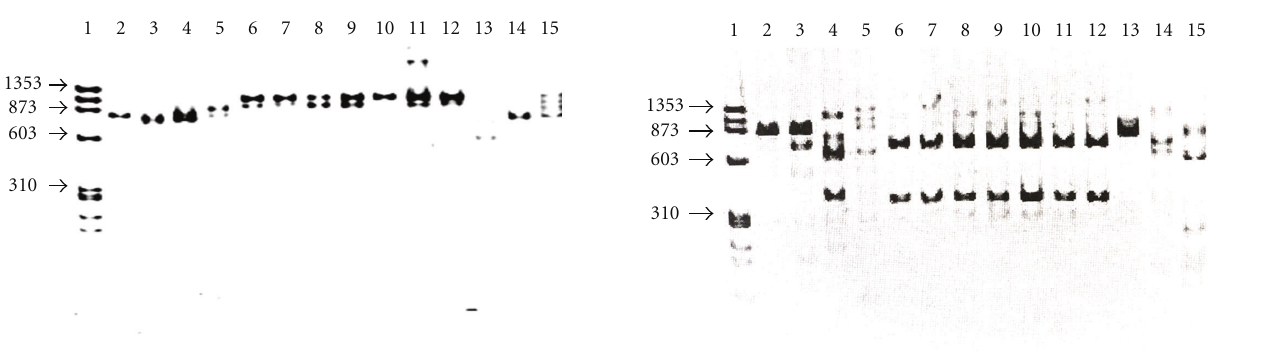
Figure 4: PCR-RFLP analysis with the endonuclease Mbo I . Lane 1, MW X174 Hae III; 2, L. (L.) garnhami JAP78; 3, L. (L.)